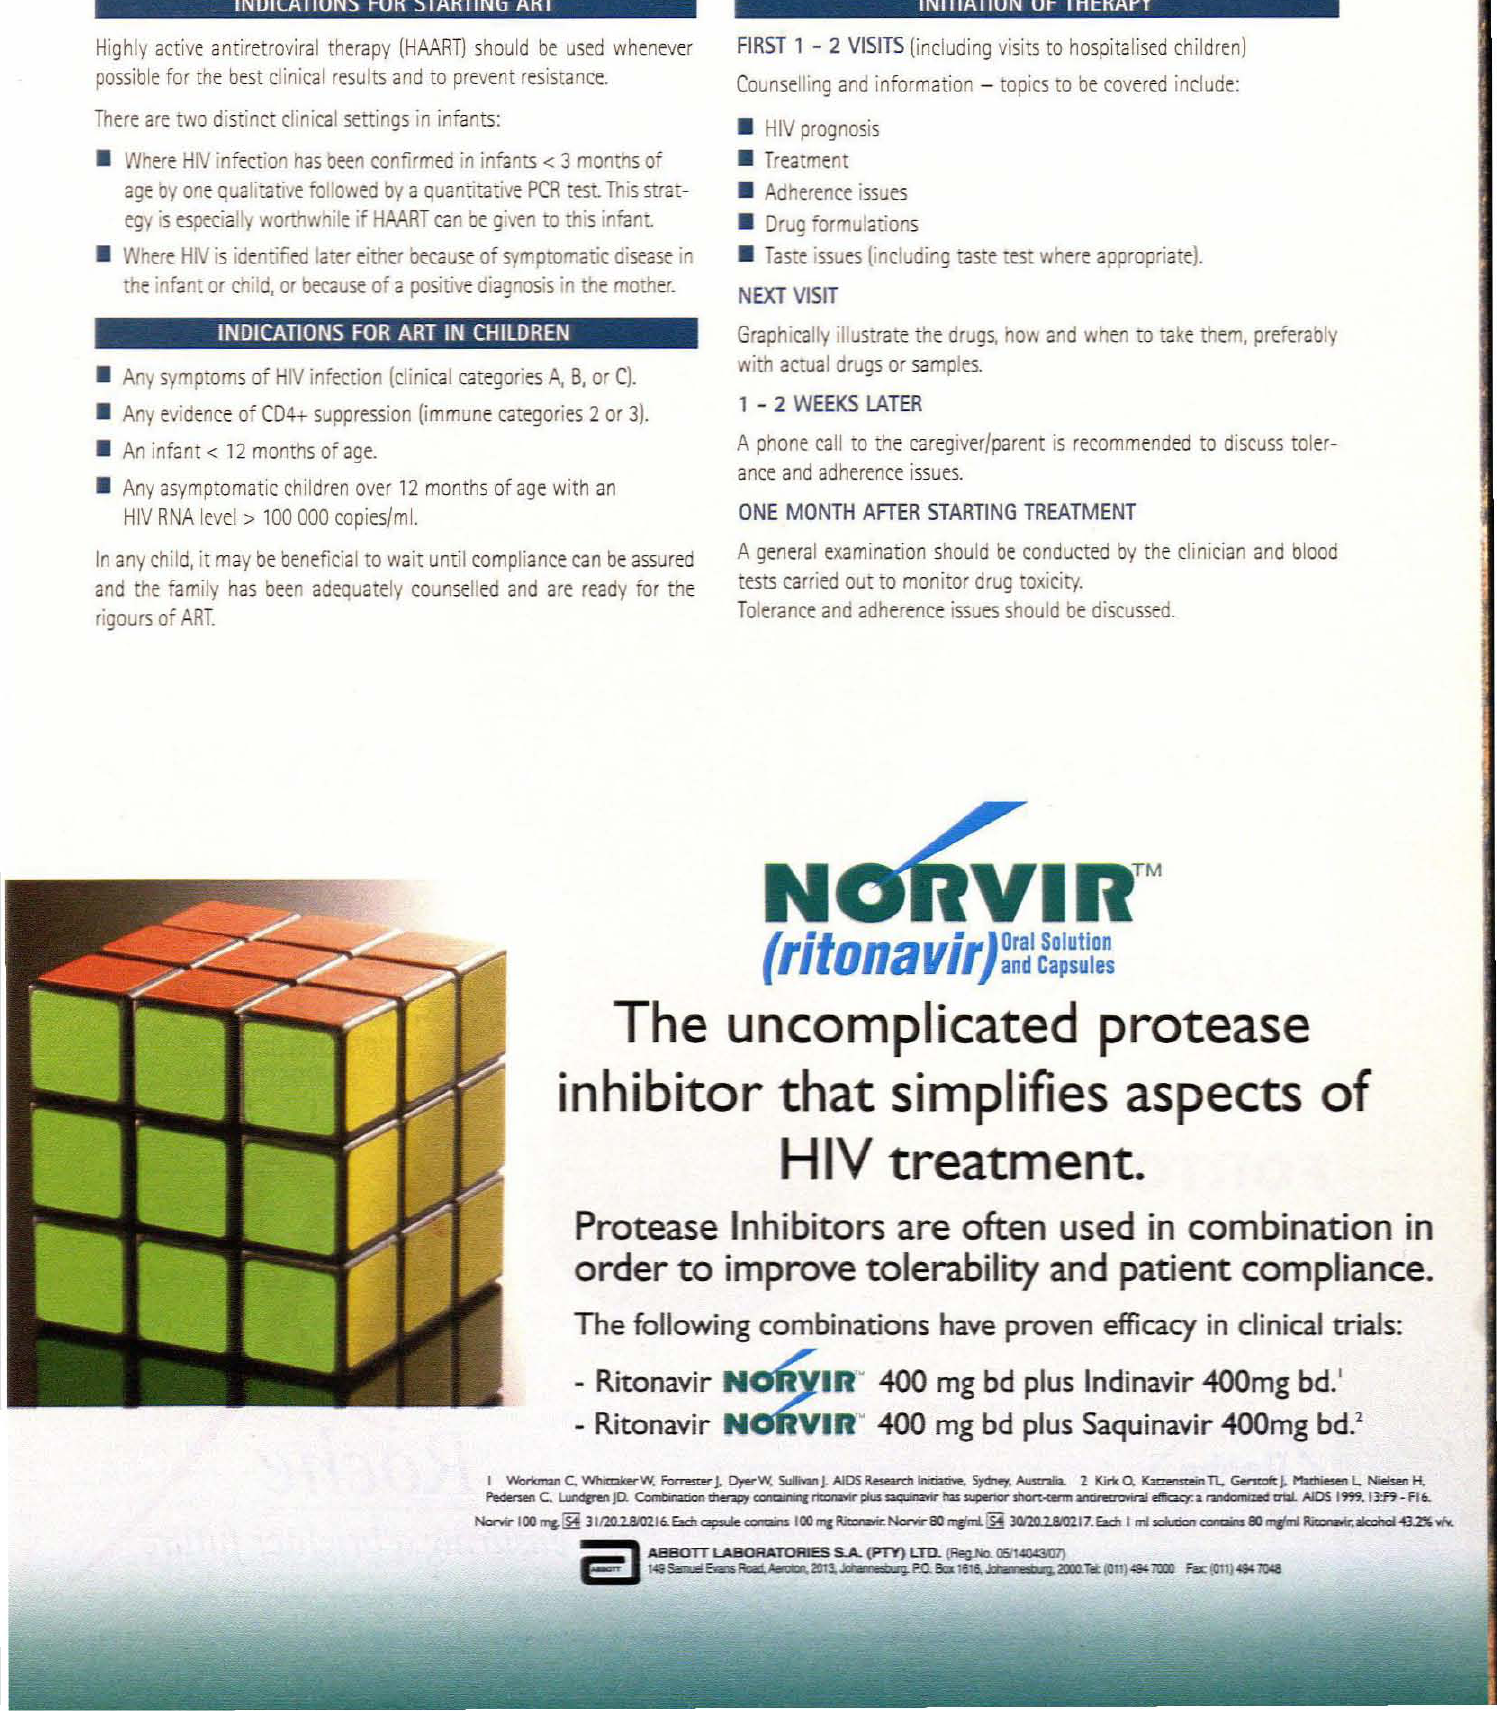
TABLE Ill. IMMUNOLOGICAL CATEGORIES FOR CHILDREN WITH HIV INFEcnON -- -------- ---------